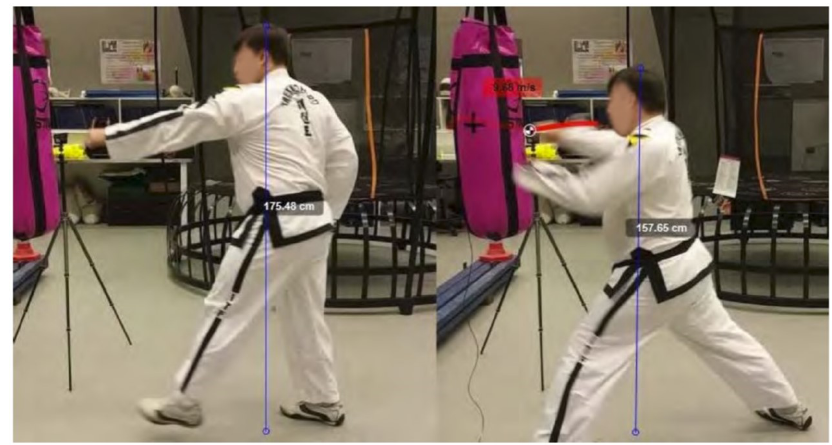
Figure 14. Sine-wave punch observed height differences during